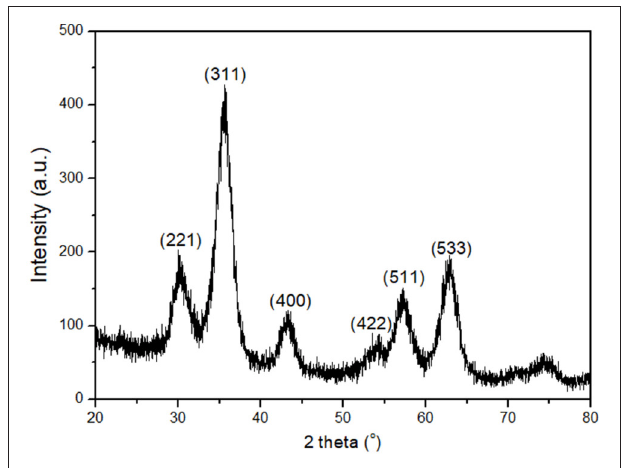
FIGURE 1 | X-Ray diffraction pattern of the γ Fe nanoparticles.